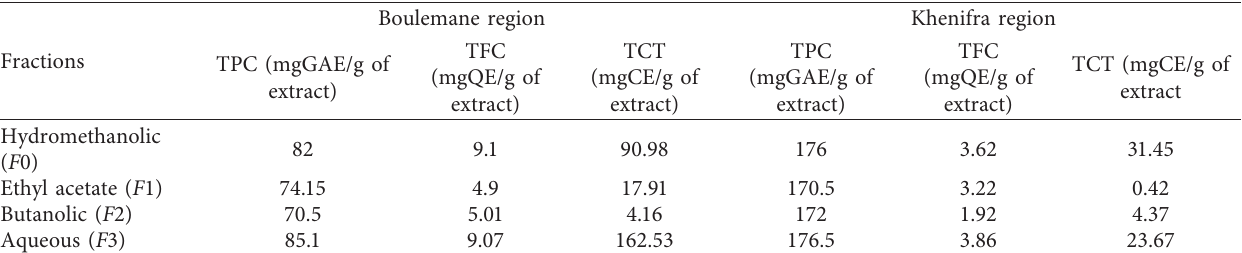
Table 1: Total concentration of phenolic (TPC), flavonoid (TFC), and condensed tannin (TCT) of hydromethanolic extract and their fractions of ethyl acetate and butanolic of Salvia officinalis L.